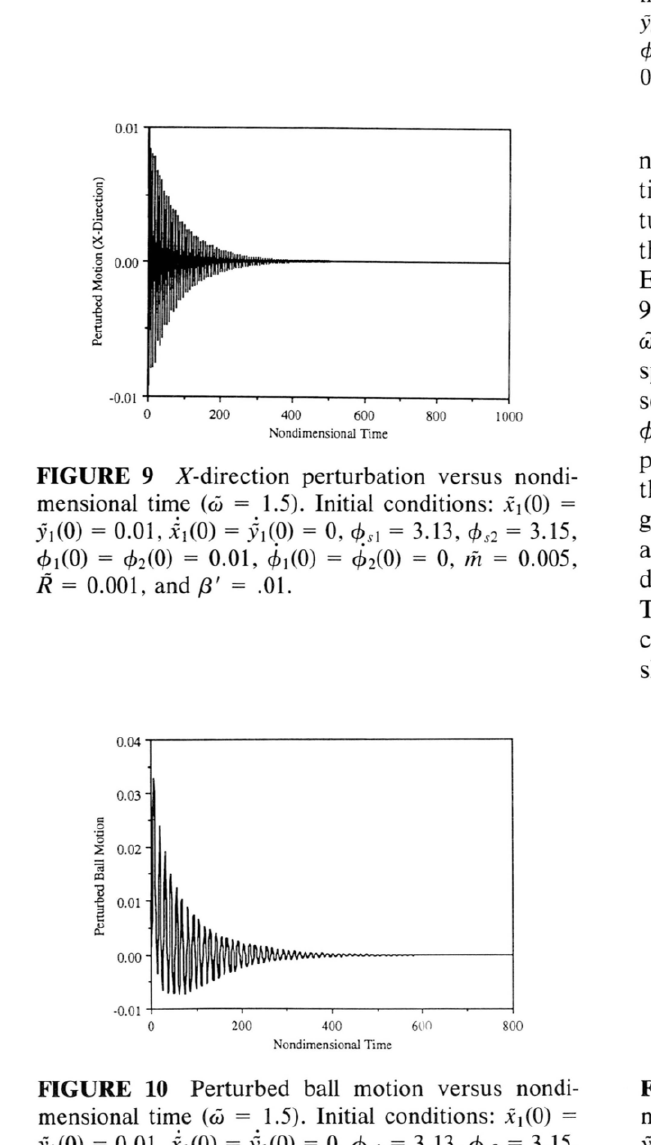
FIGURE 8 Dynamic stability diagram (w versus (3').